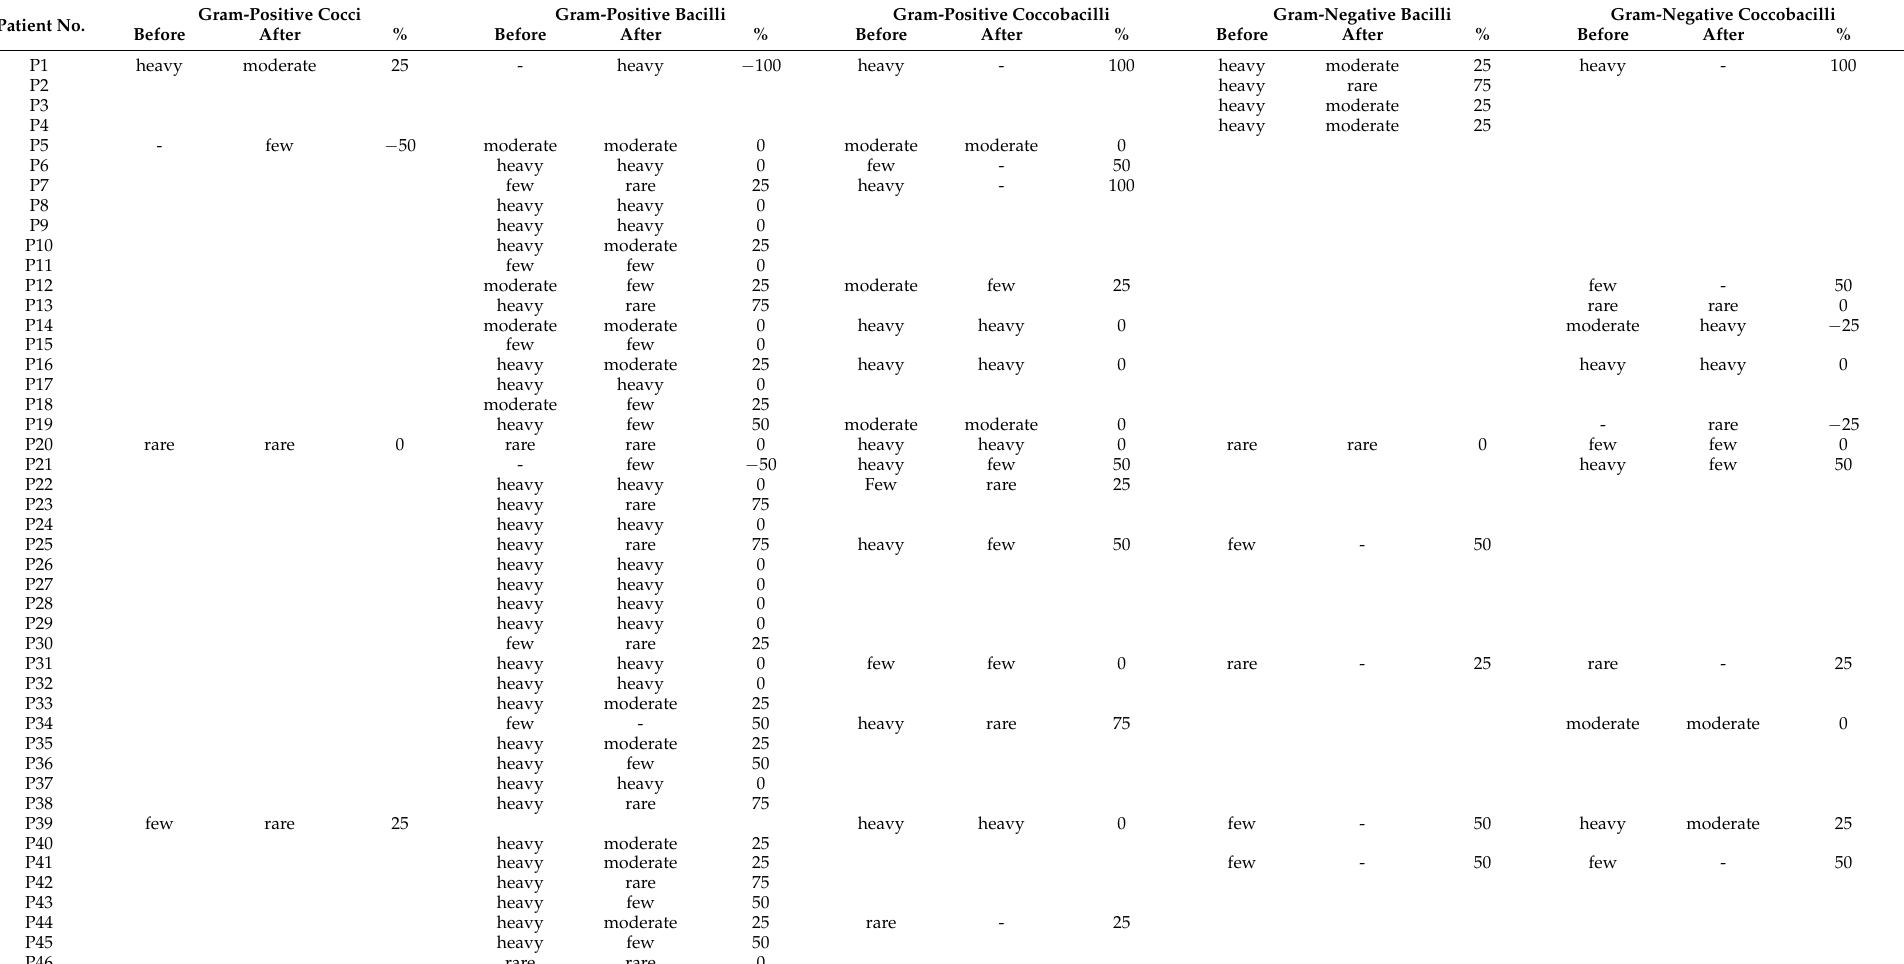
Table 4. A summary of the results of Gram stain in the plasma-activated water sprayed patients. The minus ( − ) and plus (+) signs indicate the reduction and increase of bacteria,